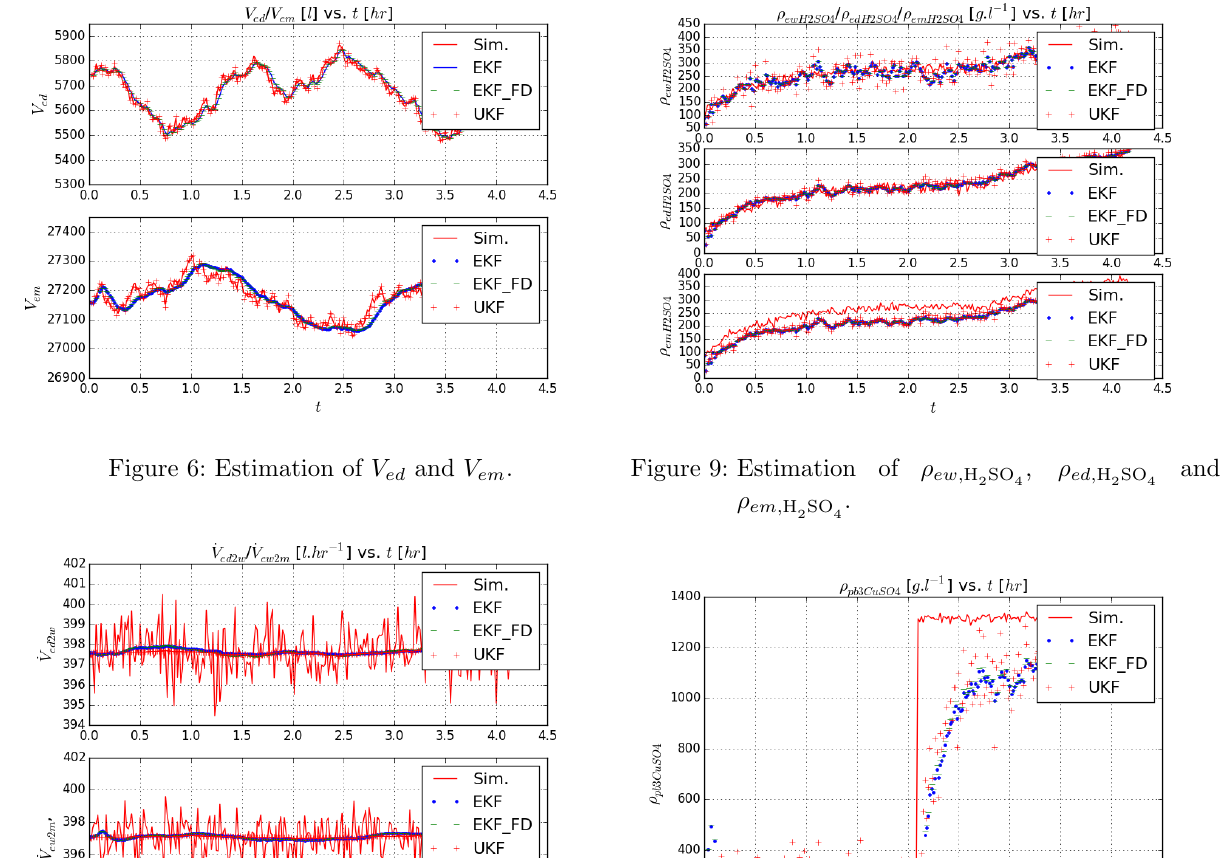
Figure 7: Estimation of ˙ V ed 2 w and ˙ V ew 2 m .